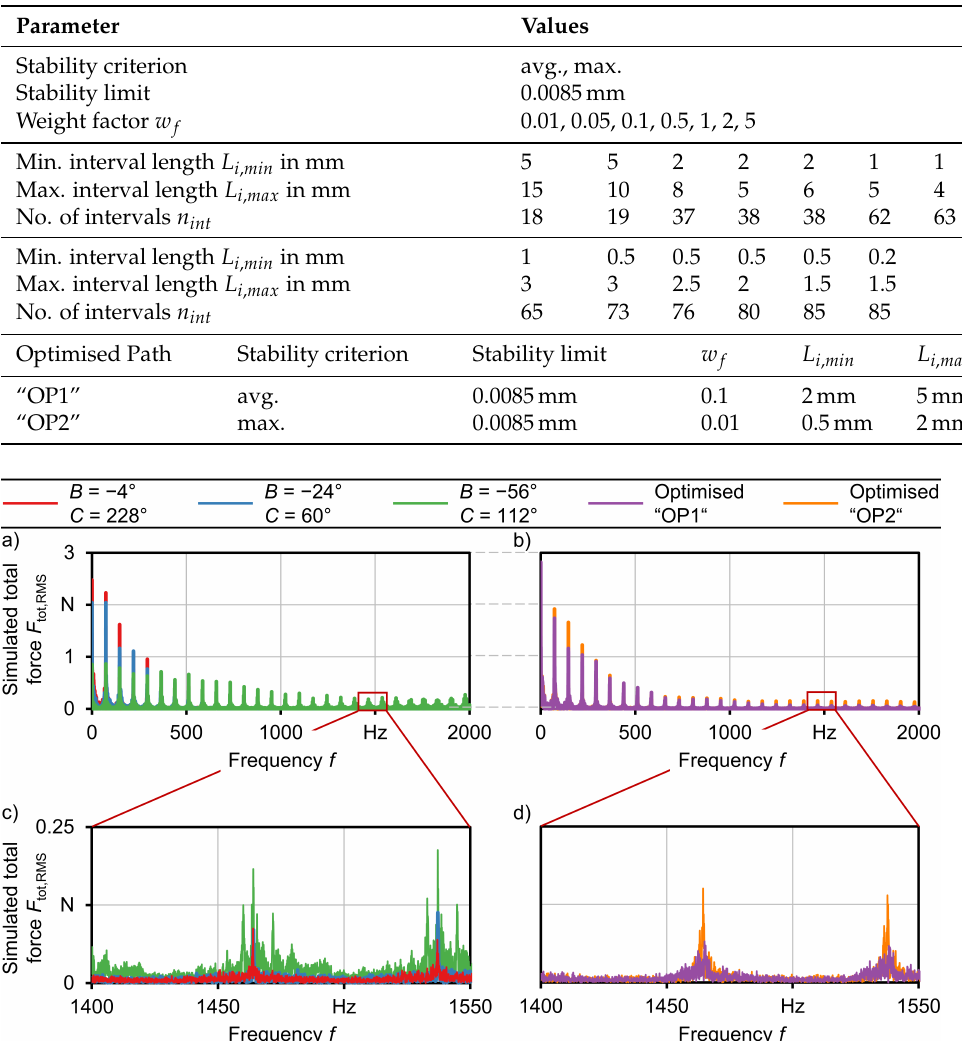
Figure 12. Root Mean Square (RMS) values of the simulated process forces over the whole process for ( a , c ) fixed B and C orientation and ( b , d ) two optimised